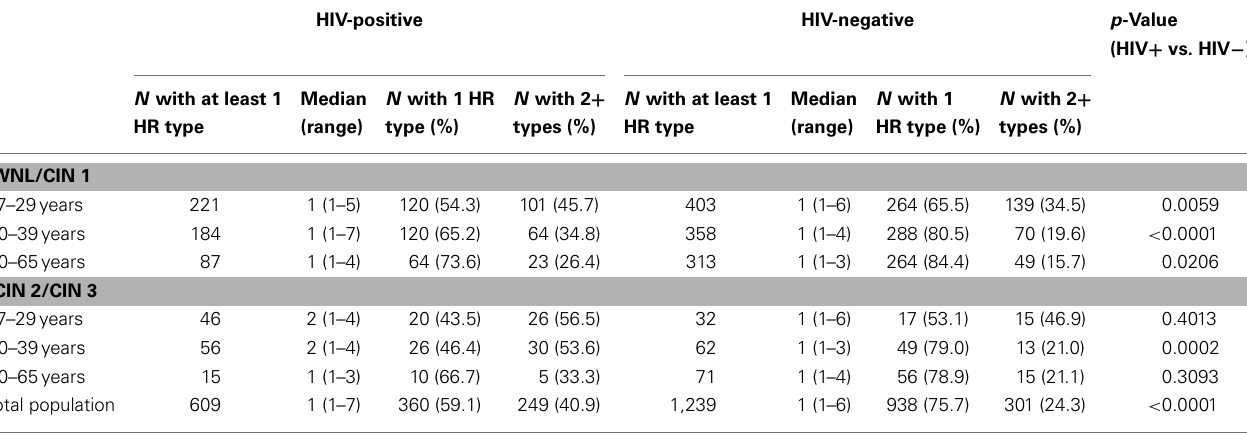
Table 4 | Multiple high-risk types in HIV-positive ( N = 609) and -negative ( N = 1,239) women by age and disease